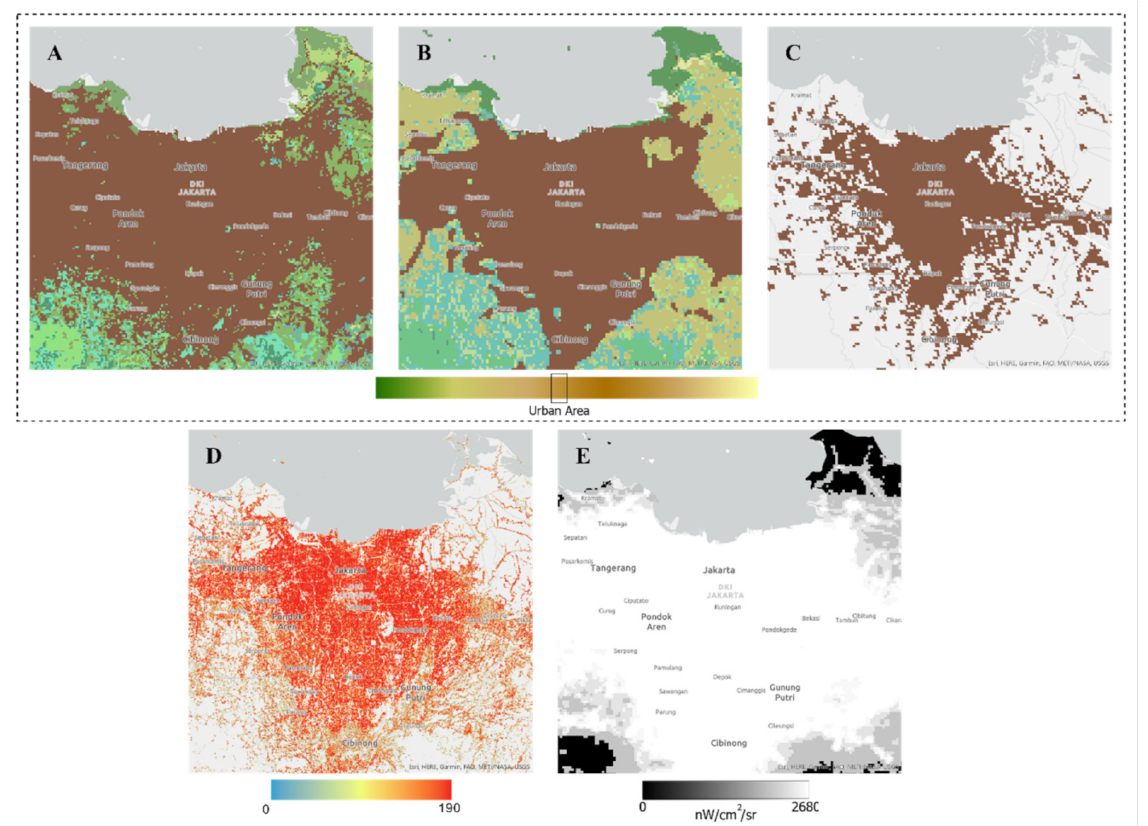
Figure 2. Remote sensing data product parameter in Jakarta Area: ( A ) LULC: ESA CCI-LC ( B ) LULC: GLCNMO ( C ) LULC: MODIS built-up, ( D ) population density: CIESIN-Facebook Connectivity Lab, and ( E ) Nightlight: